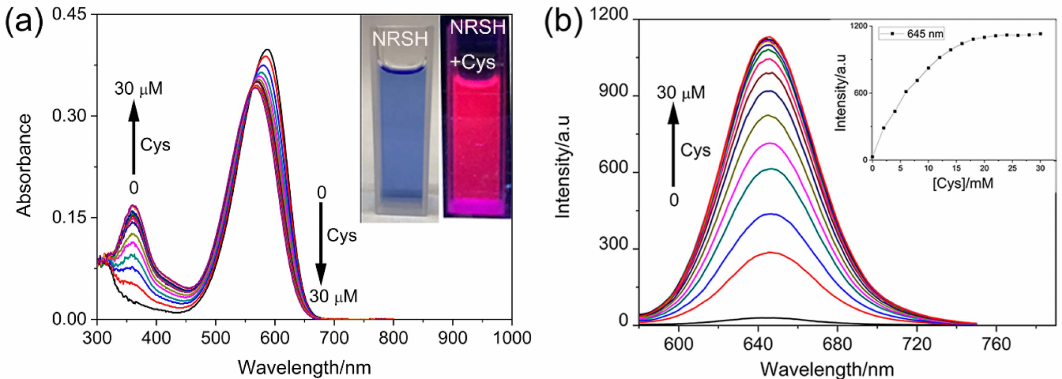
Figure 1. ( a ) Absorption titration of probe (10 µ M) toward Cys in DMSO-Tris / HCl bu ff er (10 mM, pH = 7.4 2:1, v / v ), inset: color changes observed; ( b ) Fluorescence emission of probe toward Cys, inset: plot of the fluorescence intensity of 645 nm with the concentration of Cys; Conditions: